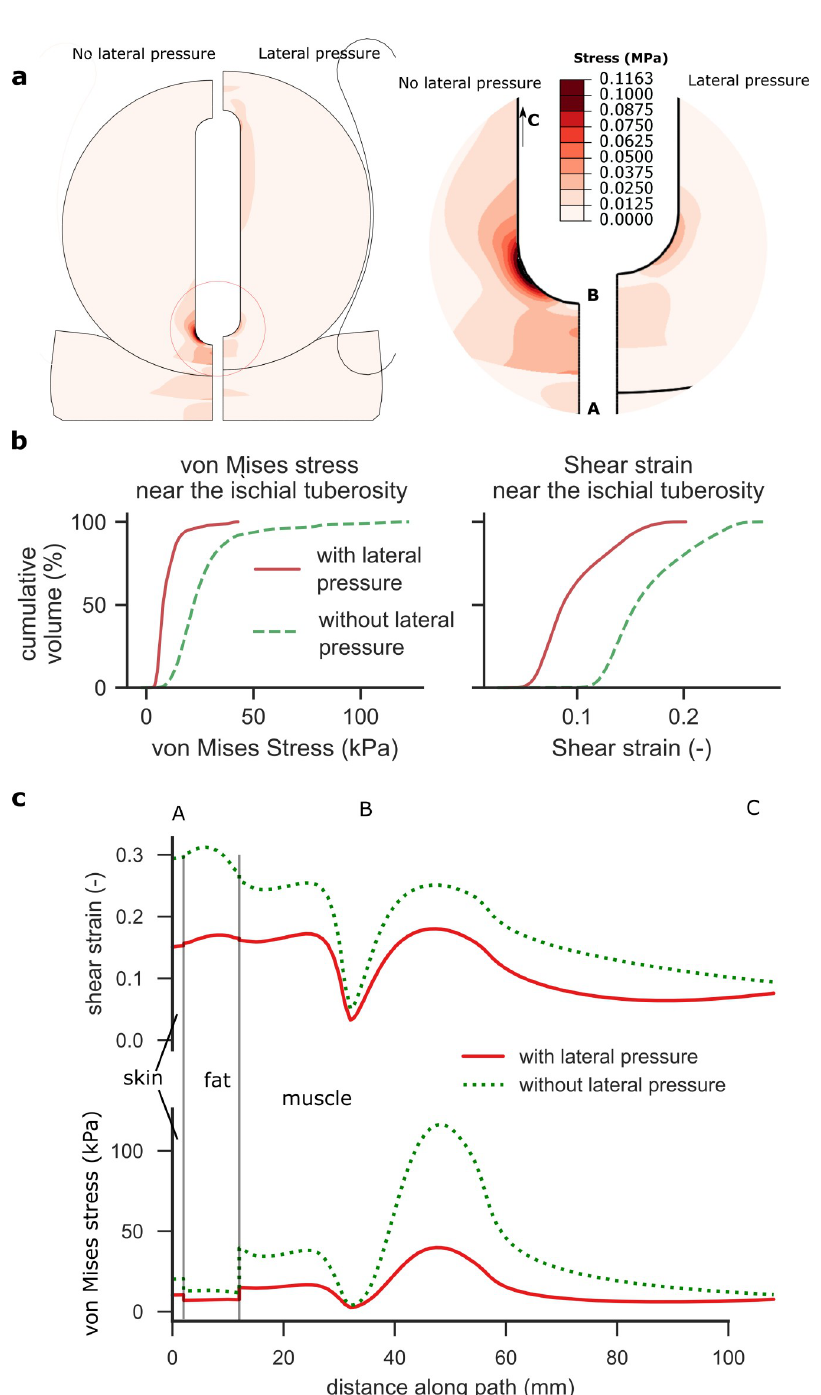
Fig 3. Analysis of load-bearing when seated on a soft cushion. In the absence of lateral pressure, the model predicts high von Mises stresses under the ischial tuberosity (a). With the introduction of lateral pressure (44 kPa chamber pressure), the region of high stress shrinks dramatically. Histograms of stresses and strains in the muscle tissue within a radius of 30 mm from the ischial tuberosity (b) indicate that von Mises stresses and shear strains are reduced. Analysis of the stress along path ABC (c) show a drop in von Mises stress and shear strain at the bony prominence, and throughout the muscle tissue. Shear strain and von Mises stress are also reduced in the skin and fat layers.